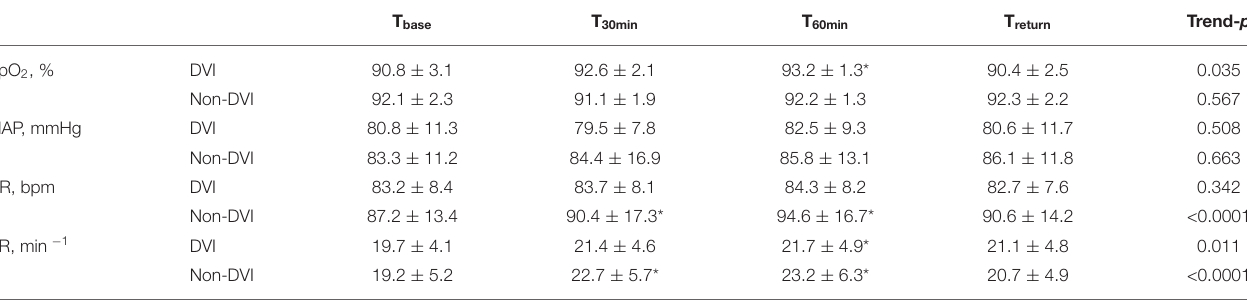
TABLE 4 | Subgroup analysis of changes of respiratory and hemodynamics parameters at different time